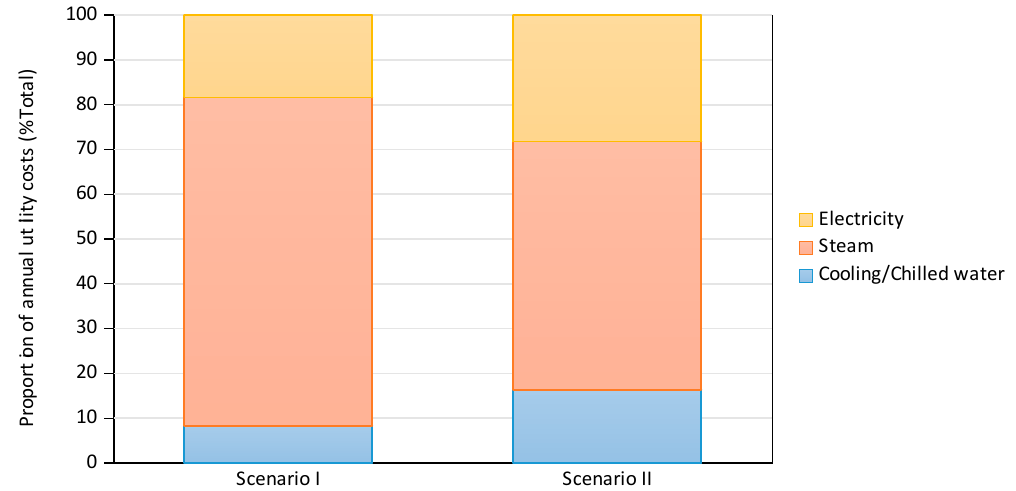
Figure 4. Proportion of annual operating costs for Scenario I (evaporation process) and Scenario II (flocculation process).